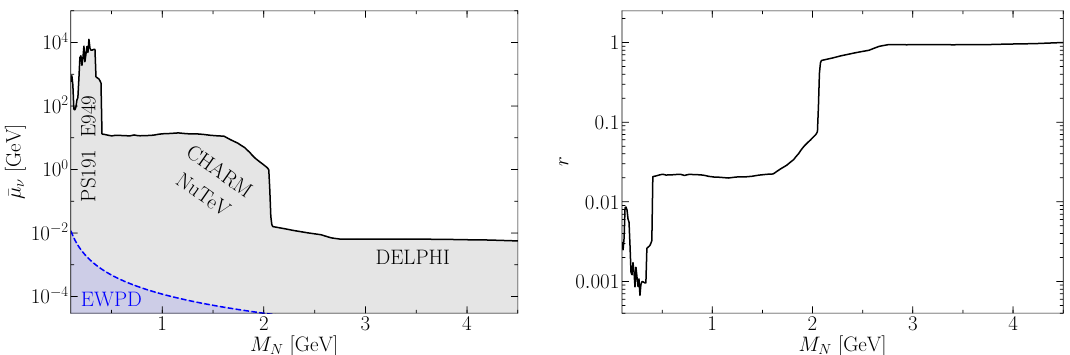
( M ), predicted by our model for the normal mass (cid:23) N N